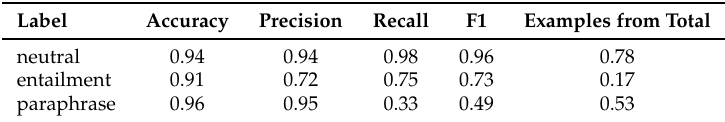
Table 4. ASSIN-PTBR NLI results per class, for the fine tuned ptBERT-Large model.